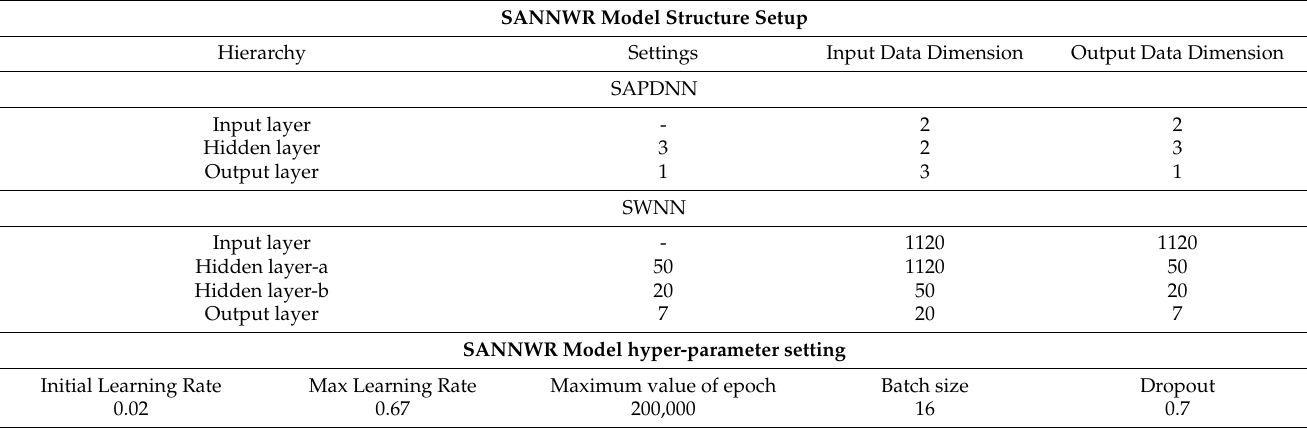
Table 2. The super parameter settings of SANNWR.